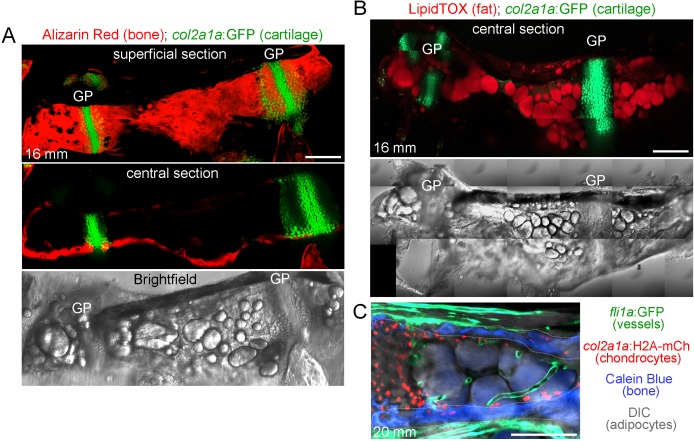
Ch bone and marrow fat structure.(A) Dissected Ch bone from a juvenile zebrafish (16 mm SL) shows staining of cartilage cells by col2a1a:GFP (green) and mineralized bone matrix by Alizarin Red. A superficial confocal section shows cortical bone along the length of the Ch, and a central section shows a lack of bone inside the Ch. Brightfield image of the same Ch shows large lipid droplets characteristic of marrow adipocytes. GP, growth plate. (B) Confocal projection of a dissected Ch (16 mm SL) from a col2a1a:GFP animal shows cartilage in green and adipocytes stained with LipidTOX in red. Brightfield image of the same Ch shows large lipid droplets overlapping with LipidTOX signal. n = 2. Scale bars = 100 μm. (C) Confocal section from a double transgenic animal (20 mm SL) shows fli1a:GFP+ blood vessels (green), col2a1a:H2A:mCherry-2A-GFPCAAX+ chondrocytes (red nuclei), Calcein Blue+ cortical bone (blue, outlined in white), and adipocytes (brightfield, grey). Note the cross-sectional and longitudinal slices through the blood vessels in the central portion of the marrow cavity (to the right of the chondrocytes and between the cortical bone). Scale bars = 100 μm (A,B), 50 μm (C).